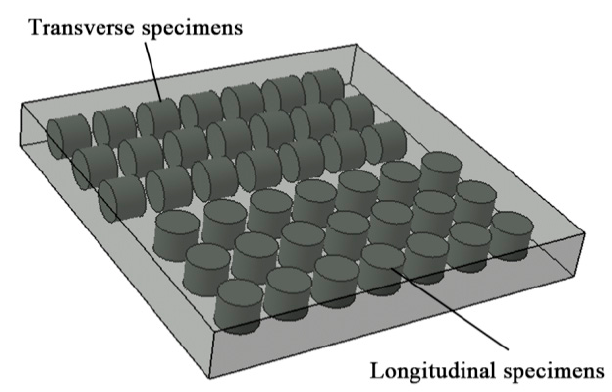
Figure 4. Sampling method of mechanical specimens.